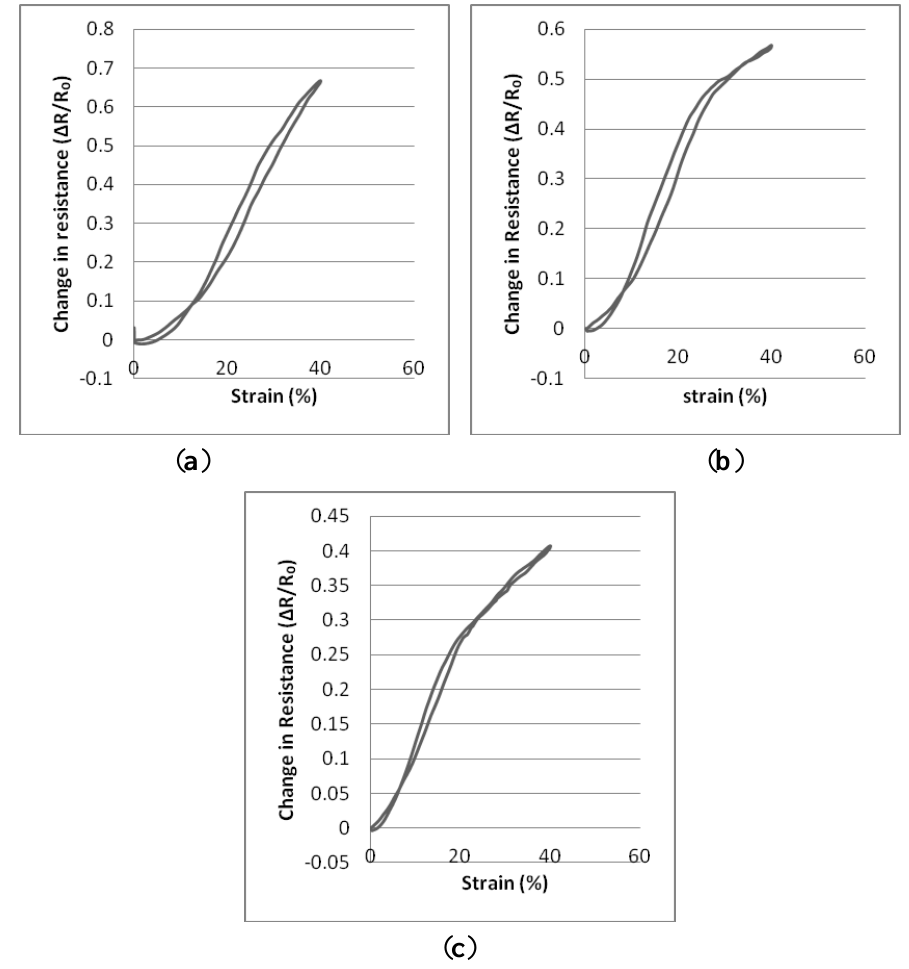
Figure 7. Relative change in resistance-strain graphs of the sensors ( a ) 5 cN conductive yarn input tension; ( b ) 10 cN conductive yarn input tension; ( c ) 20 cN conductive yarn input